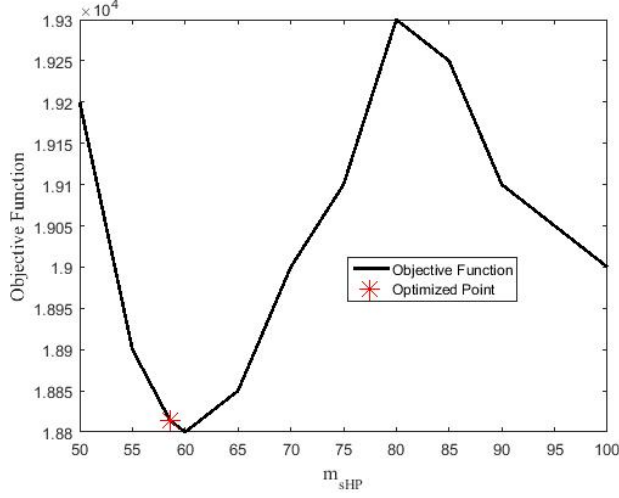
Figure 6. Variations in the objective function with the steam flow rate of the HP.